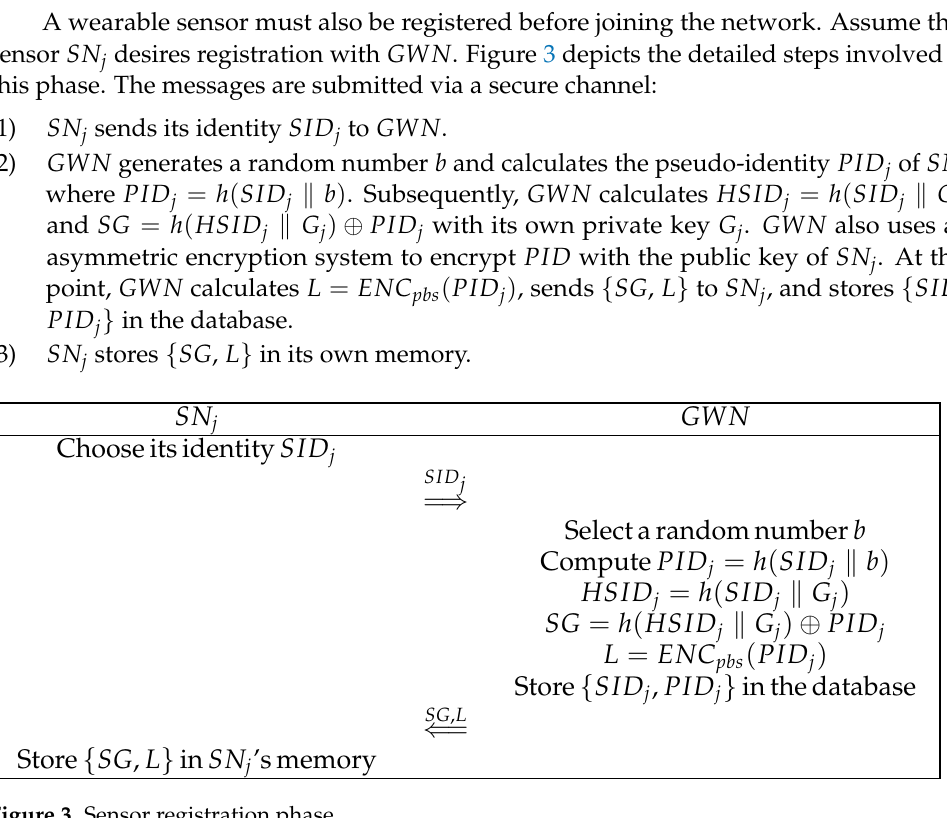
Figure 3. Sensor registration phase